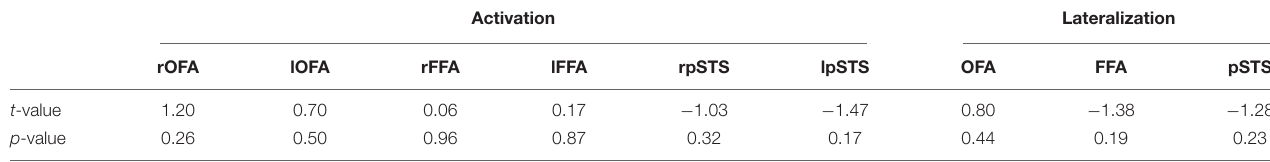
TABLE 1 | T - and p -values of the Welch t -test, comparing activation and lateralization differences between adults and children for OFA, FFA, and